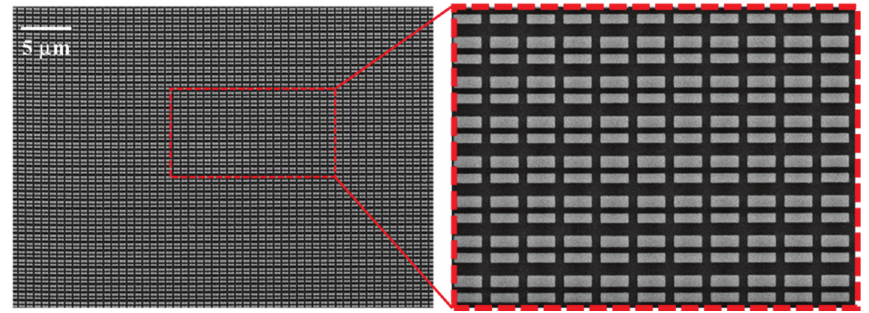
Figure 3: SEM image of the fabricated quasi-BIC. Top-view SEM images of the nanostructure (left) and zoom (right), clearly evidencing the asymmetry of the nanostructure in order to excite the Fano mode. The SEM images show the successful fabrication of our device with good